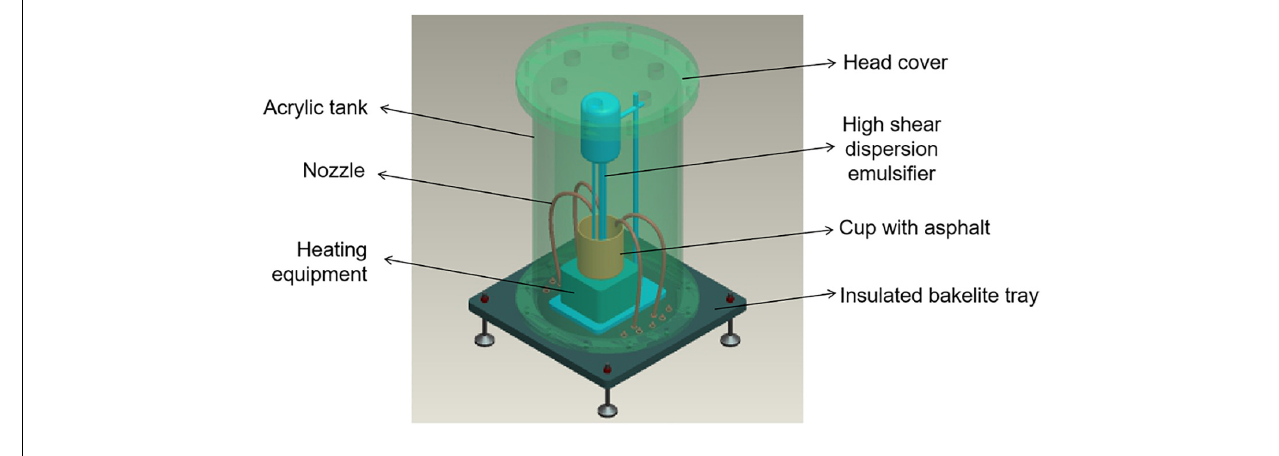
FIGURE 1 | Schematic diagram of nitrogen environment box.